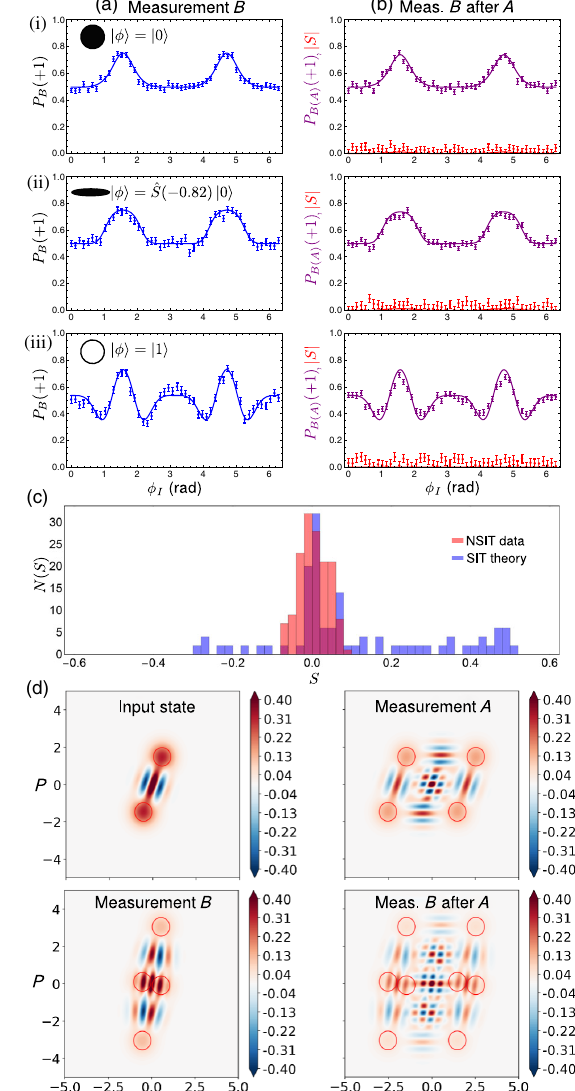
FIG. 3. NSITof modular position and momentum measurements for a variety of input states. Rows (i) – (iii) show NSIT of A to B for the measurement settings α B ¼ i π , α A ¼ 4 . 09 ≈ 4 π = j α B j , and